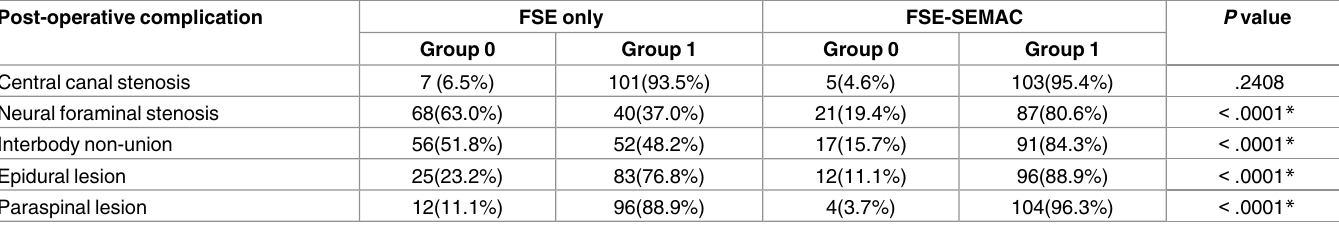
Table 4. Diagnostic confidence of postoperative